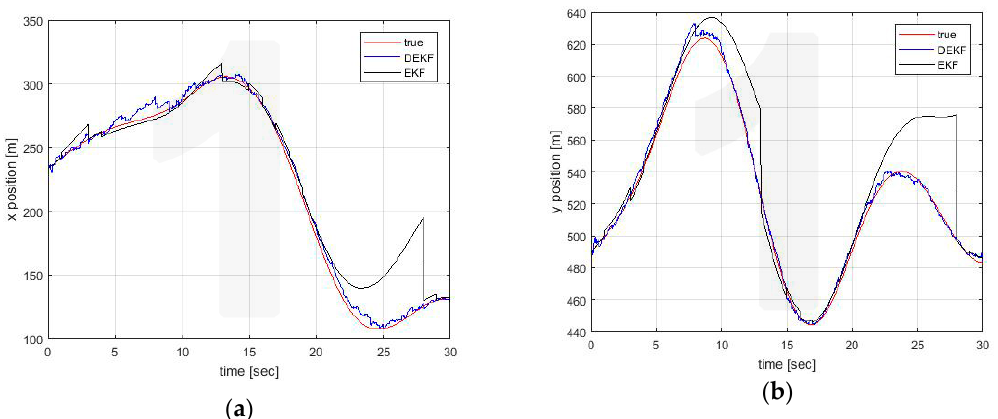
Figure 5. Position estimation performed by Vehicle 1 on its own position ( a ) x axis ( b ) y axis.